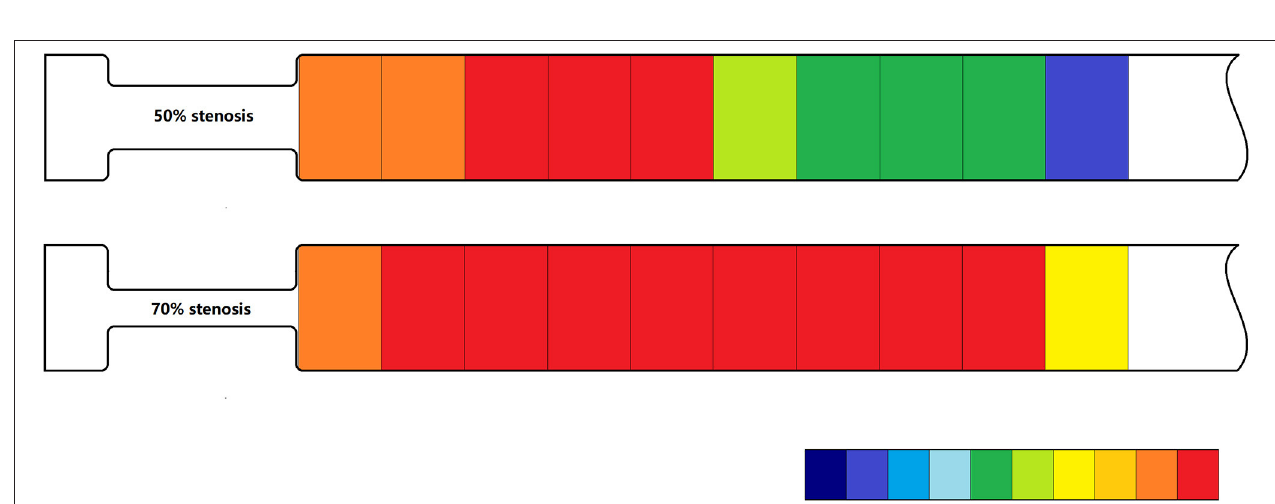
FIGURE 3 | Percentage of Tur indices ( > 1%) in relation to distances distal to a 50% stenosis (above) and a 70% stenosis (below) in 12 canine femoral